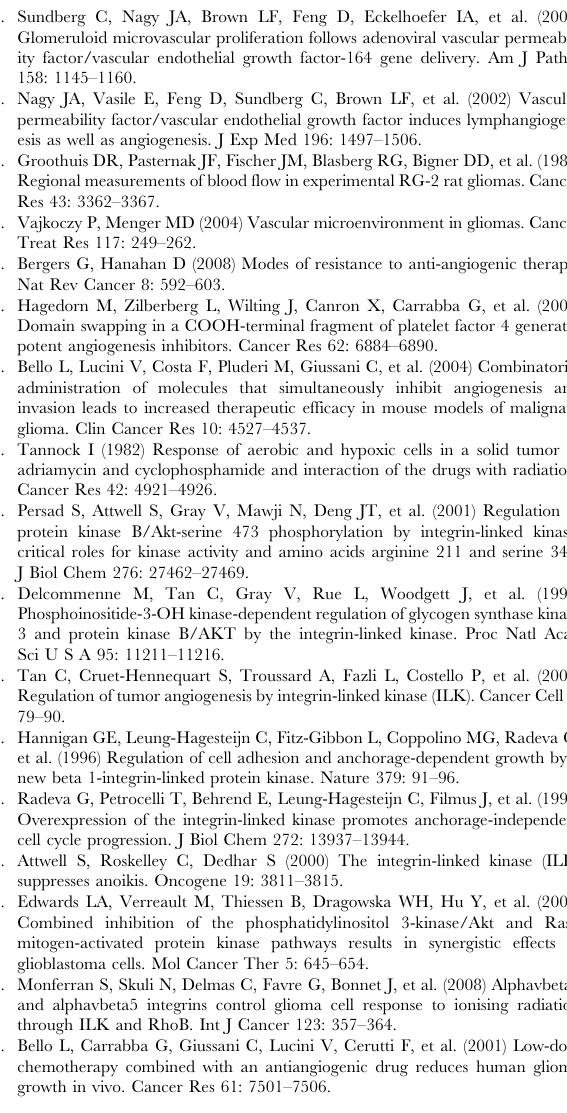
Table S2 ILK1 knockdown experiment